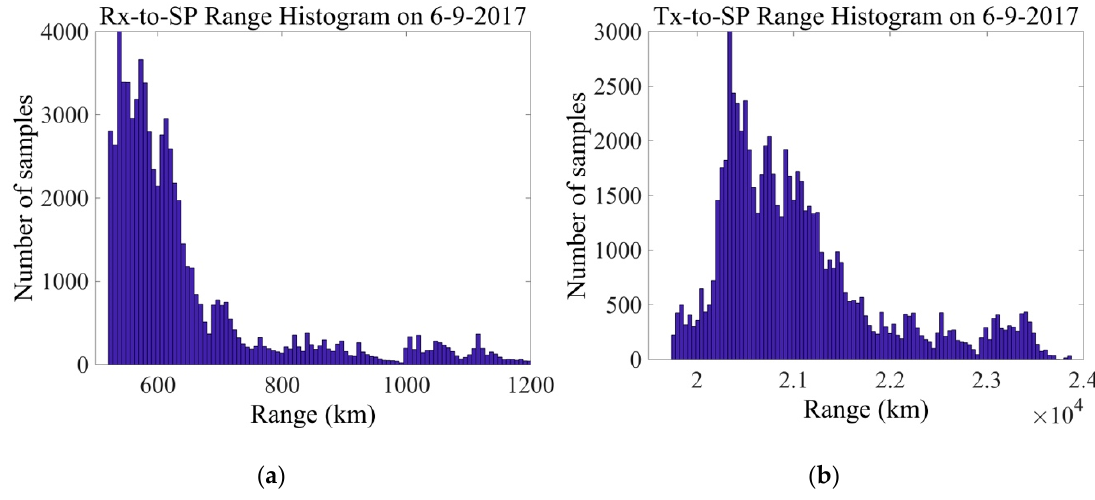
Figure 1. Histogram of propagation distances: ( a ) r R (from specular point to CYGNSS receiver); ( b ) r T (from GPS transmitter to specular point) for a full day of samples on 9 June 2017.